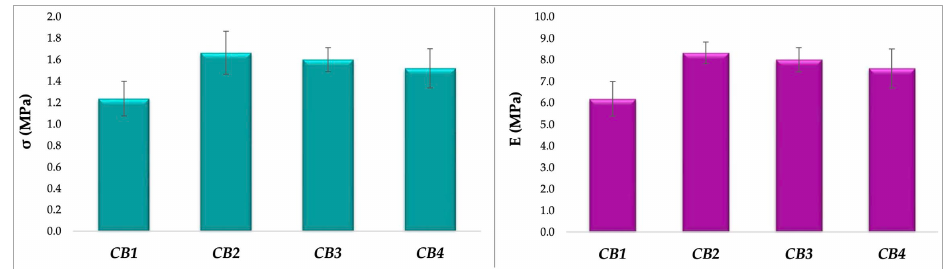
Figure 6. CBs mechanical features: compressive strength — σ ( left ) and Young’s Modulus — E ( right ). The σ values for beads were obtained in the range of 1.23 MPa (CB1) and 1.66 MPa (CB2), comparable with those of human trabecular bone, placed between 0.1 and 16 MPa,